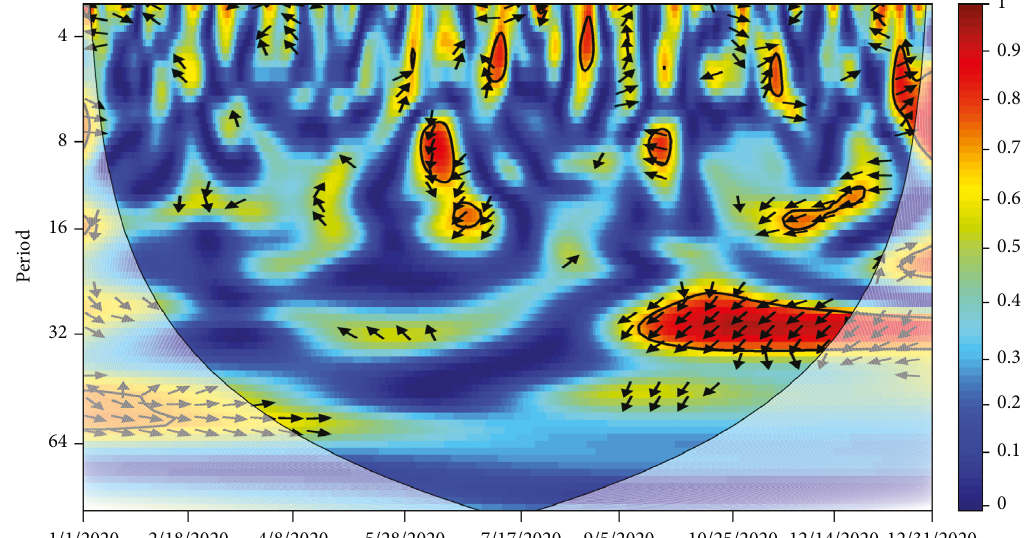
Figure 4: The wavelet coherency between illiquidity and IDEMV (tranquil period). Note: this figure reports the wavelet coherency between illiquidity and IDEMV during tranquil period. The black contour represents the regions in which the spectrum is significant at the 5% level against red noise. The cone of influence denoted as COI is designated by the lighter shade which delineates the high power regions. Time and scale (days) are represented on the horizontal and vertical axes, respectively. Arrows pointed to the right (resp. left) signify that the variables are in phase (out of phase). If arrows move to the right and up (resp. down), the first variable is the driver (resp. follower). By contrast, if arrows move to the left and up (down), the second variable is leading (resp. lagging).